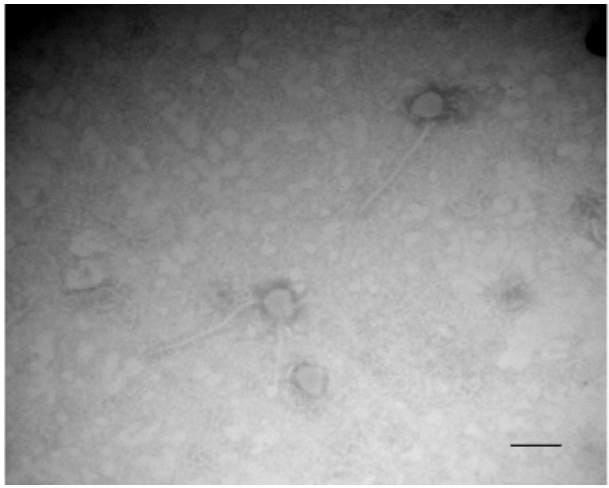
Figure 3. Transmission electron microscopy of phages in the supernatant of S. xylosus after induction with mitomycin C. Bar, 100 nm. Magnification, ×120,000.